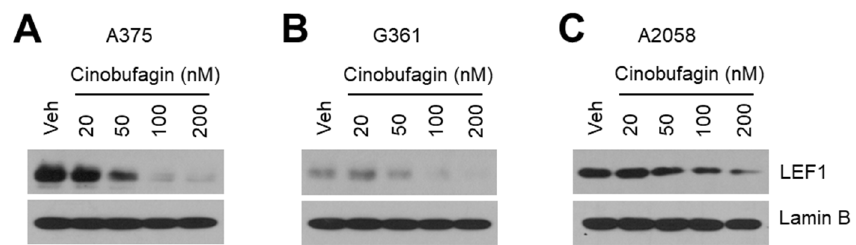
Figure 3. Cinobufagin decreases LEF1 expression in melanoma cells. ( A – C ) Cinobufagin suppresses nuclear LEF1 protein levels in a dose-dependent manner in A375 ( A ), G361 ( B ), and A2058 ( C ) melanoma cells. Cells were incubated for 24 h with different concentrations of cinobufagin as indicated. After cinobufagin treatment, nuclear protein was isolated and protein levels were measured by Western blotting.